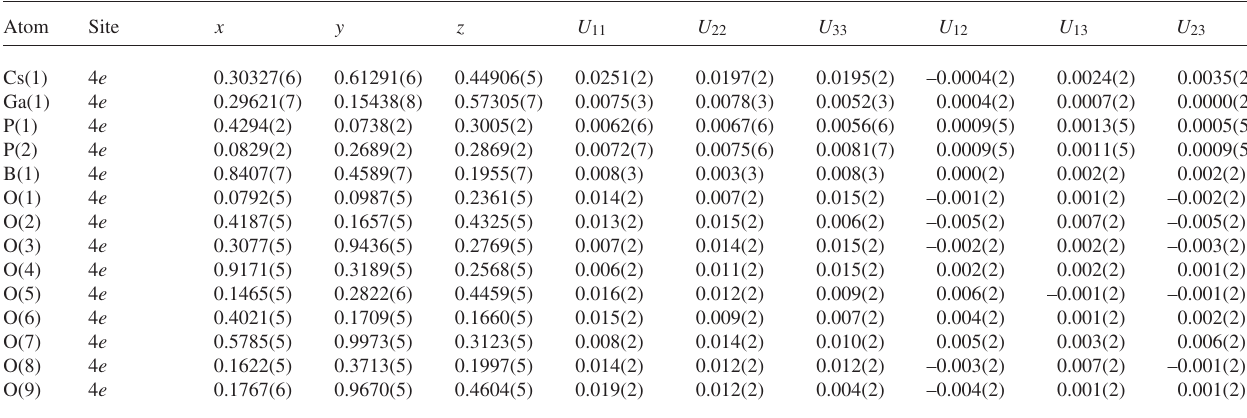
Table 3. Atomic coordinates and displacement parameters (in Å 2 ) .